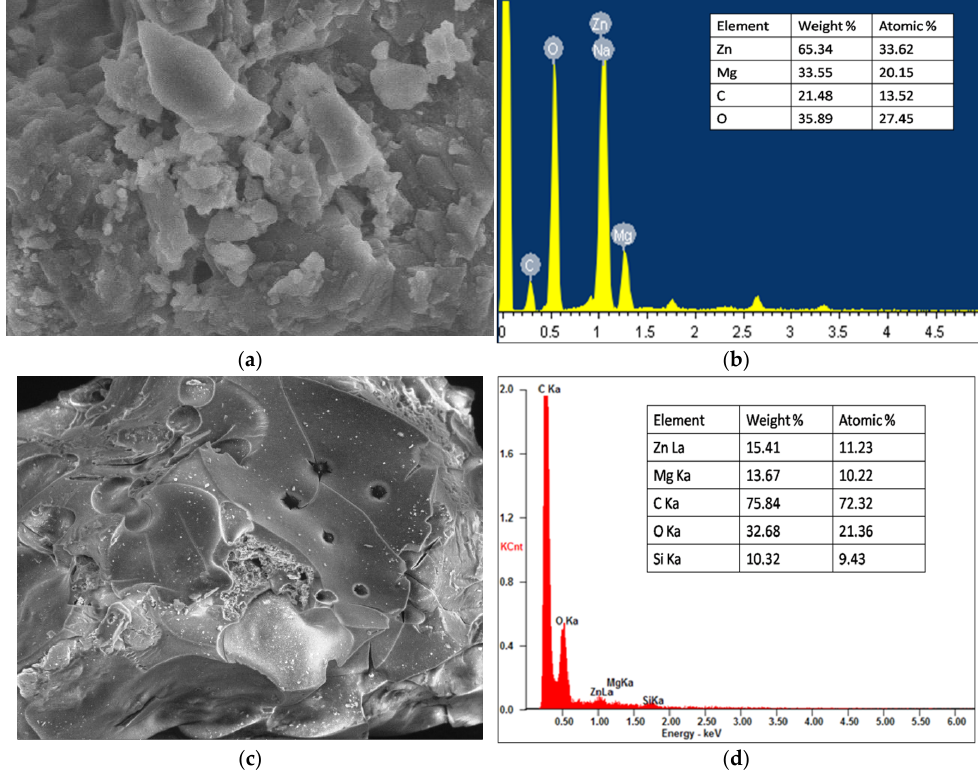
Figure 3. SEM images of ( a ) Zn 50 Mg 50 O and ( c ) G-Zn 50 Mg 50 O and EDAX spectra of ( b ) Zn 50 Mg 50 O and ( d ) G-Zn 50 Mg 50 O.